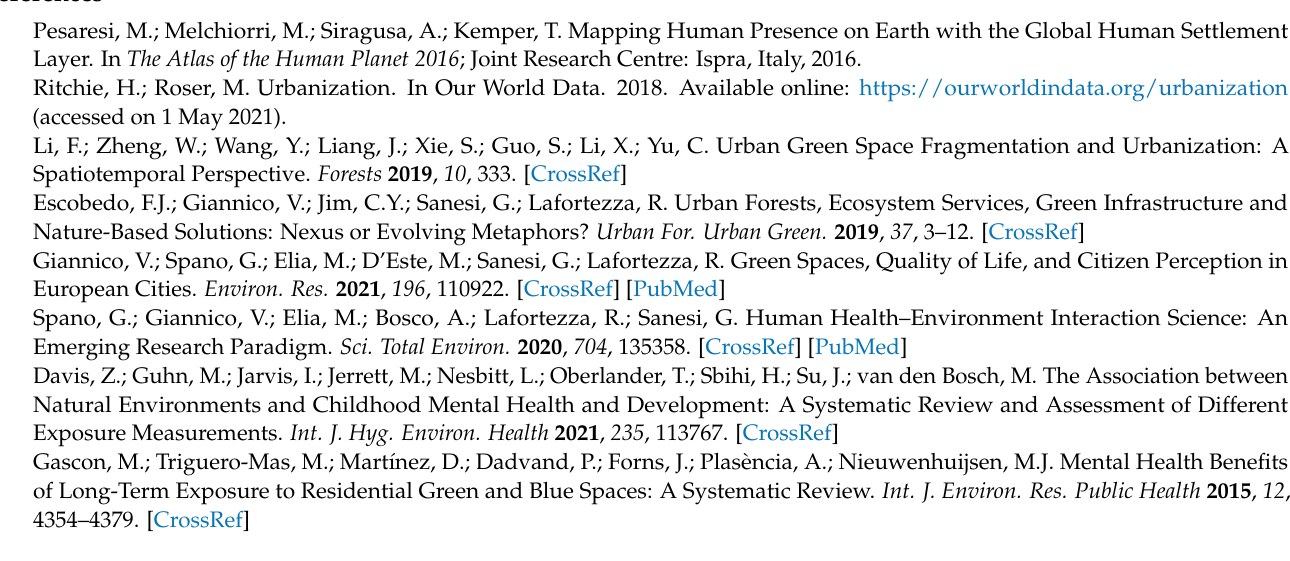
Table S2, Quality assessment of the available evidence; Table S3, Characteristics of greenspace expo- sure